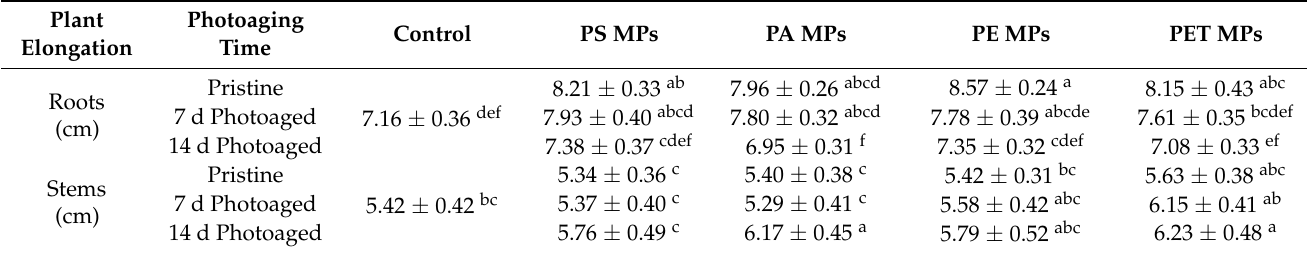
Figure 3. The ( a ) germination rate of sprouts, ( b ) the number of lateral roots, and the soluble sugar content in ( c ) roots and ( d ) stems after 7 d of exposure to 100 mg L −1 different MP suspensions. The number of samples for the repeated experiments is n = 3. Data are expressed as the mean ± SD. Different lowercase letters indicate significant differences between experimental groups ( p < 0.05). Table 1. The root elongation and stem length of seedlings after 7 d of exposure to 100 mg L −1 different MP suspensions. The number of samples for the repeated experiments is n = 3. Data are expressed as the mean ± SD. Different lowercase letters indicate significant differences between experimental groups ( p < 0.05).